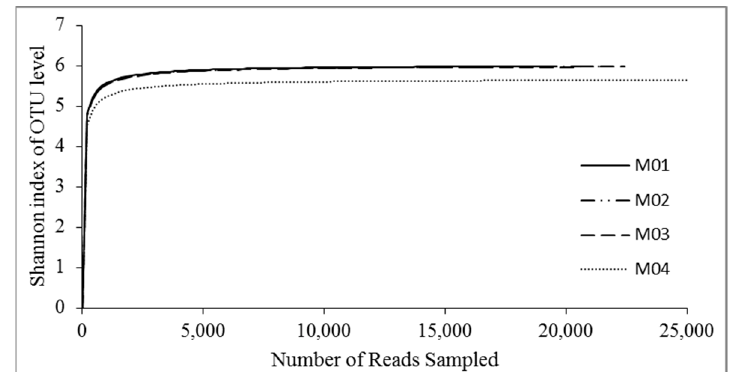
Figure 6. A sample microbial dilution curve.